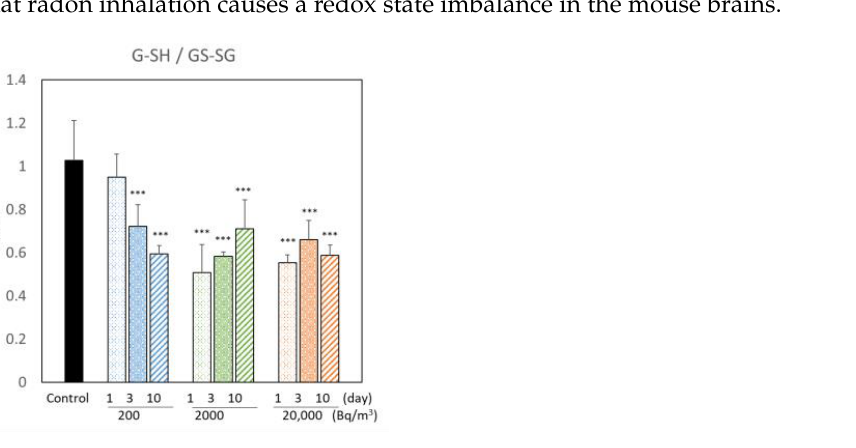
Figure 4. Changes in G-SH/GS-SG by radon inhalation. The number of mice per experimental point is six. All quantitative data are presented as mean ± SD. *** p < 0.001. vs. control.